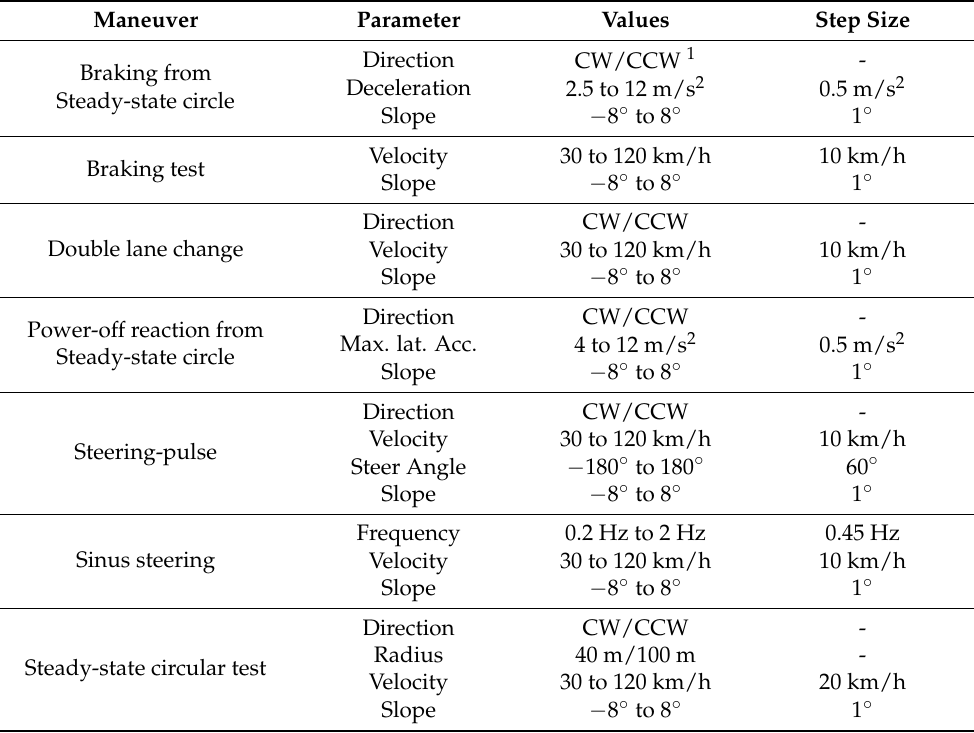
Table 2. Driving maneuver catalog that is used to generate training, test, and validation data. Maneuver Parameter Values Step